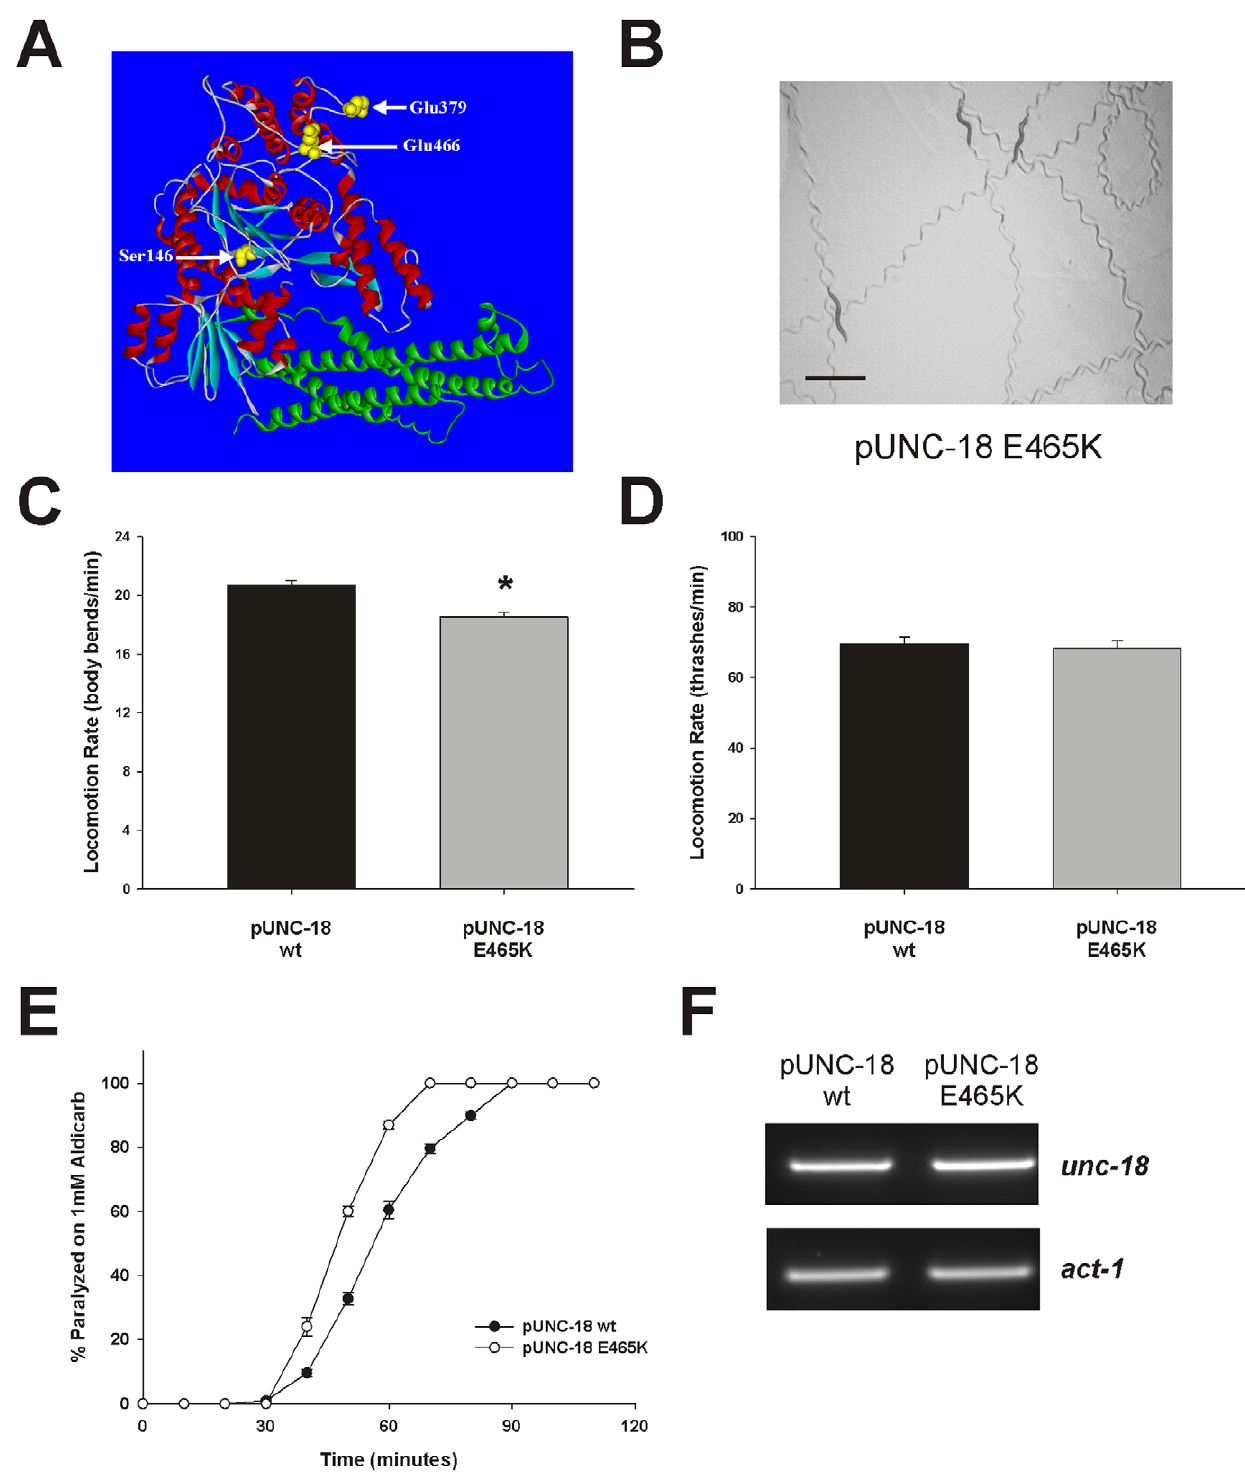
Figure 6. Transgenic Caenorhabditiselegans expressing the E465K UNC-18 point mutation are hypersensitive to the effects of aldicarb. (A) Structure of Munc18-1 protein indicating the position of the E466K point mutation in comparison to the Ser146 and Glu379 insertion mutations. (B) The unc-18 ( e81 ) null mutant was rescued with a transgenic construct expressing E465K UNC-18 (orthologous mutation to Munc18-1 E466K). The photograph depicts trails left in OP50 E. coli from 5 rescued worms after 5 minutes. Scale bar =1 mm. Locomotion rate for transgenic rescues was again quantified by counting body bends (C) or thrashing (D). There was a minimal reduction in locomotion rate as assessed by body bends (*; p , 0.01); however, there was no significant difference as assessed by thrashing. Data were analysed from 20 pUNC-18 wildtype and 40 pUNC-18 E465K (body bends) and 81 pUNC-18 wildtype and 80 pUNC-18 E465K worms (thrashes). (E) The E465K point mutation worms were hypersensitive to the effects of aldicarb in comparison to wildtype (wt) rescues. Experiments were performed on a population of 20-25 adult hermaphrodite worms exposed to 1 mM aldicarb. Determination of paralysis and analysis were as described in the previous figure. (F) mRNA